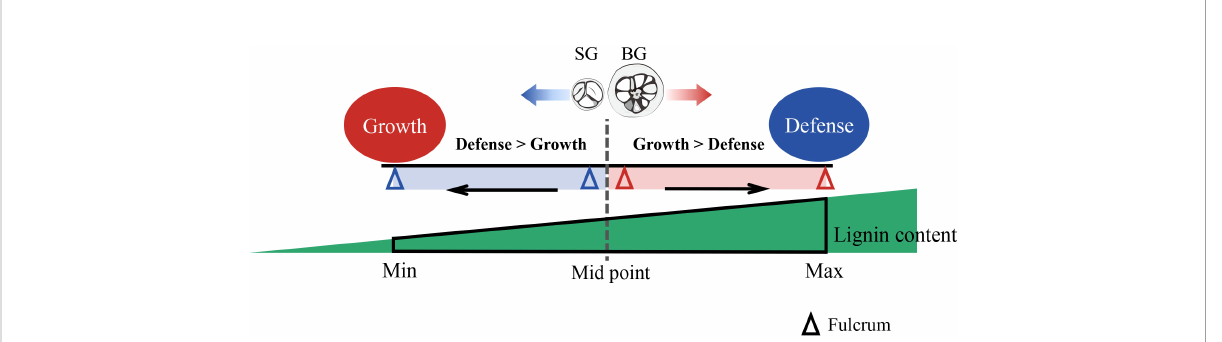
FIGURE 5 Proposed schematic of lignin-regulated growth – defense tradeoffs in Camellia. Lignin content (red triangle) within a certain threshold (from Min to Max) acts as a fulcrum to balance the resource fl ux into the plant growth and defense: A tendency of growth bias (BG) or defense bias (SG) is precisely tuned by the lignin level in pericarps. BG, C. drupifera ; SG, C. oleifera ; S-lignin, syringyl lignin; GO, gene ontology; KEGG, Kyoto Encyclopedia of Genes and Genomes; TBO, toluidine blue O; OPLS-DA, orthogonal partial least-squares discrimination analysis; VIP, variable importance in projection; DAMs, differentially accumulated metabolites; DEGs, differentially expressed genes; FC, fold change; FDR, false discovery rate; qRT-PCR, quantitative real-time polymerase chain reaction; PCA, principal component analysis; S-unit, sinapyl alcohol; G-unit, coniferyl alcohol; H-unit, coumarate conjugate; C3 ’ H, p-coumarate 3-hydroxylase; CSE,S caffeoyl shikimate esterase; COMT, caffeic acid O- methyltransferase; CAD, cinnamyl alcohol dehydrogenase; C4H, cinnamate 4-hydroxylase; PAL, L-phenylalanine ammonia-lyase; POD, peroxidases; LAC, laccases; TF, transcription factor; ERF38, ethylene response factor 38; WIN1/SHN, wax inducer1/SHINE1; SPT, SPATULA; WRKY44, WRKY transcription factor 44; PR, pathogenesis-related; HCT, quinate/shikimate p-hydroxy cinnamoyl